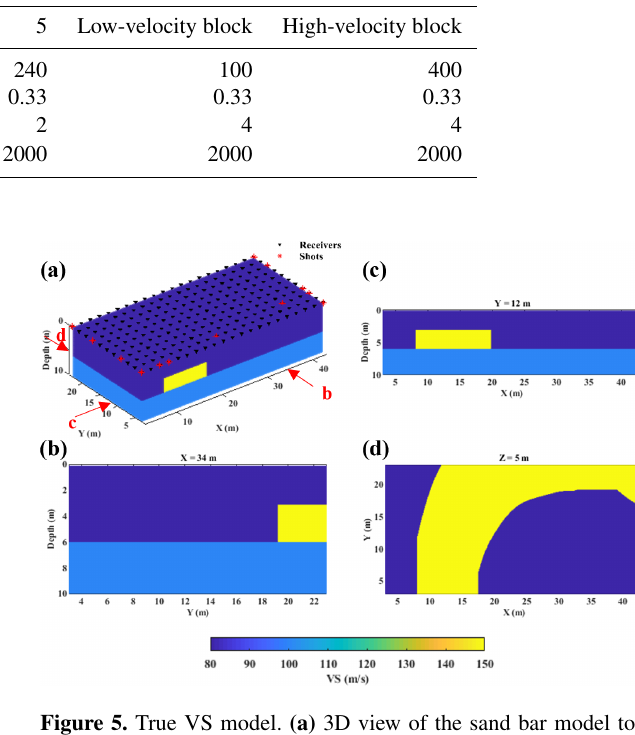
Figure 5. True VS model. (a) 3D view of the sand bar model to- gether with the acquisition geometry. The arrows show the location of the cross-section in the corresponding subfigure. (b) Vertical slice at X = 34m, (c) vertical slice at Y = 12m, (d) horizontal slice at 5m depth.